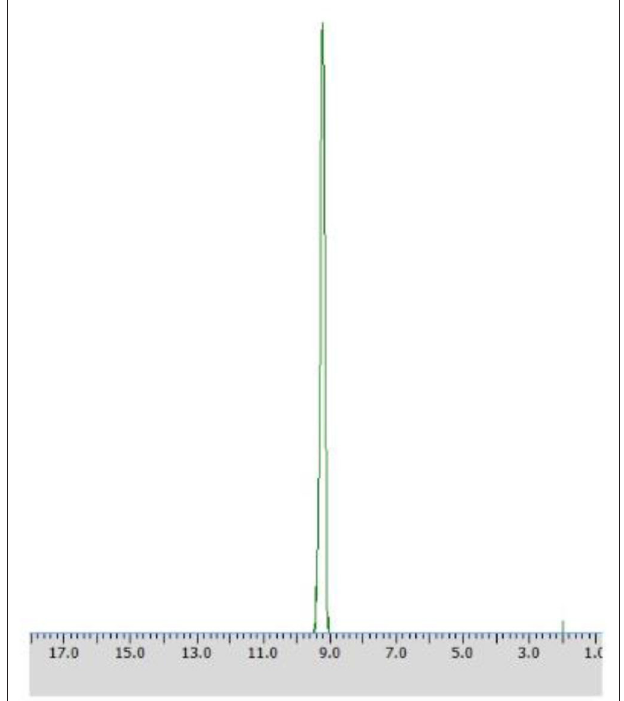
FIGURE 4 | 31 P NMR spectra of post-bioconversion mixture recorded with the addition of CSA, after the biotransformation of racemic 1-amino-1-(2-thienyl)methylphosphonic acid using Rhodotorula mucilaginosa as biocatalyst (Method A3).